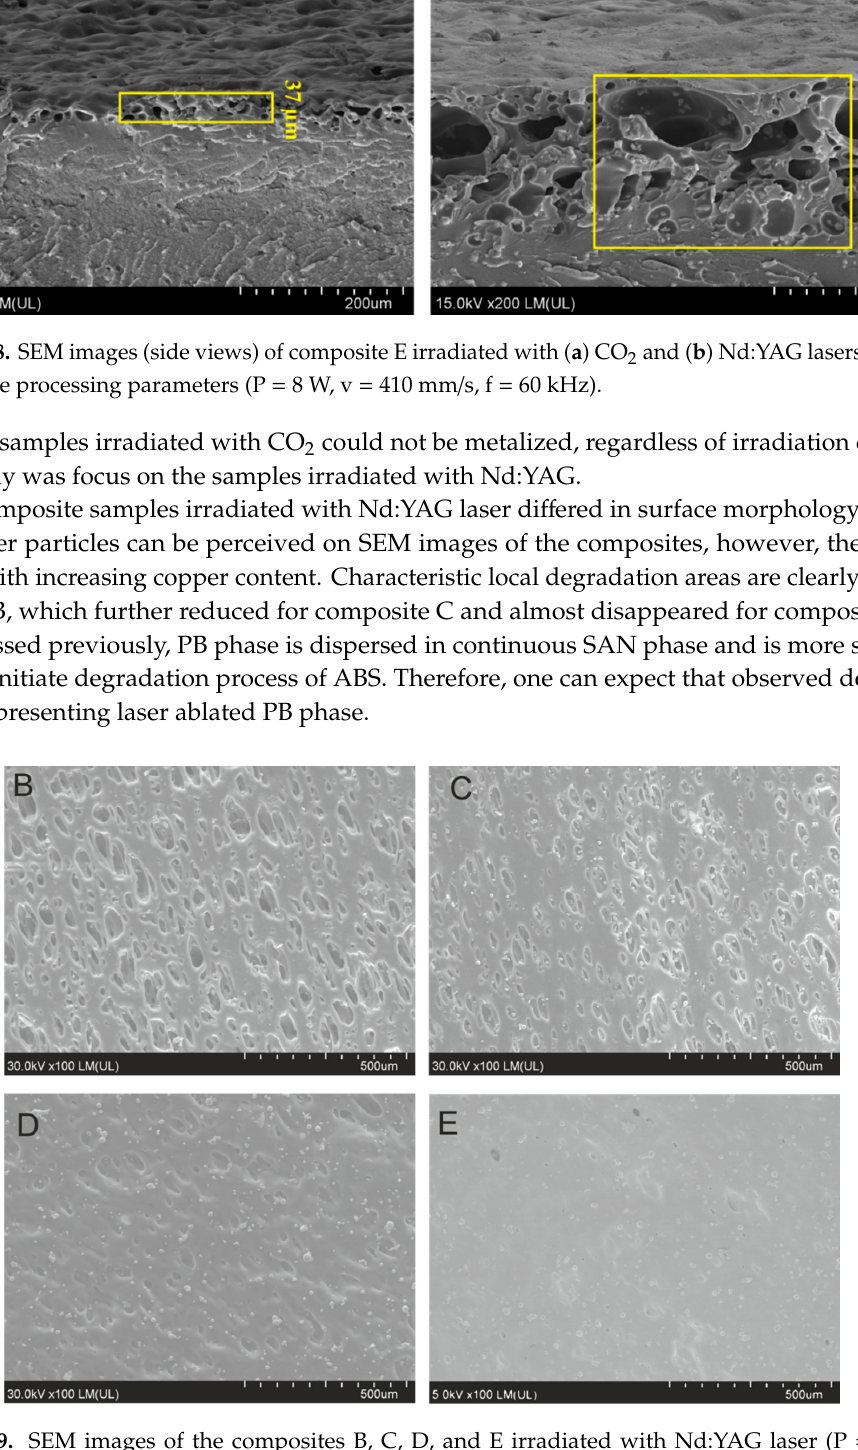
Figure 9. SEM images of the composites B, C, D, and E irradiated with Nd:YAG laser (P = 8 W, v = 410 mm/s, f = 60 kHz).